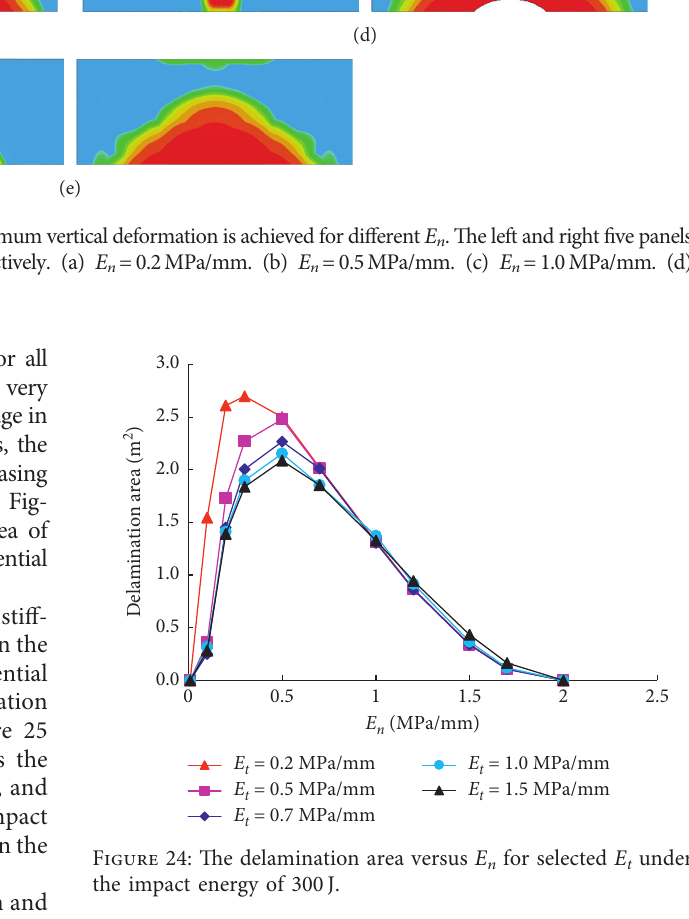
n for selected E t under